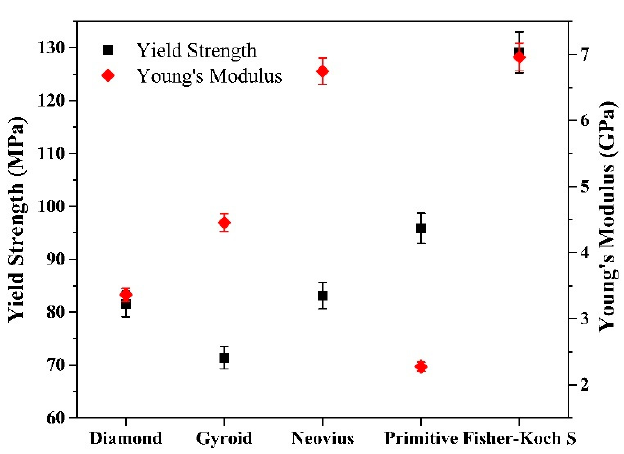
Figure 6. Young’s Modulus and yield strength of the different functionally graded lattice samples.